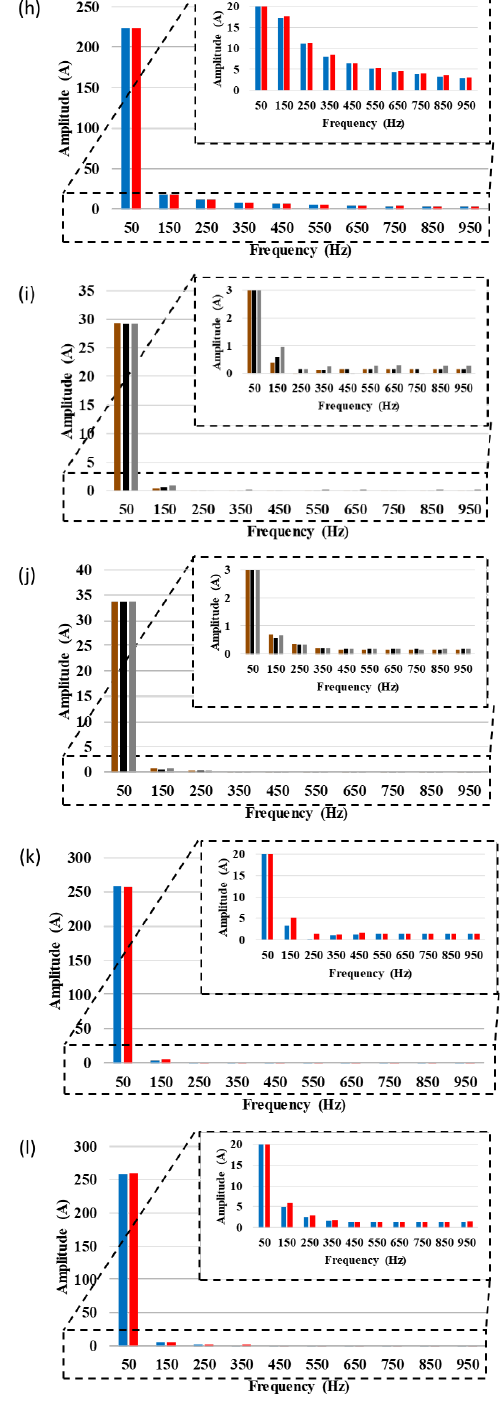
Figure 12. Harmonic spectrum of the currents in the three-phase power grid and in the catenary, before and after STATCOM or RPC compensation